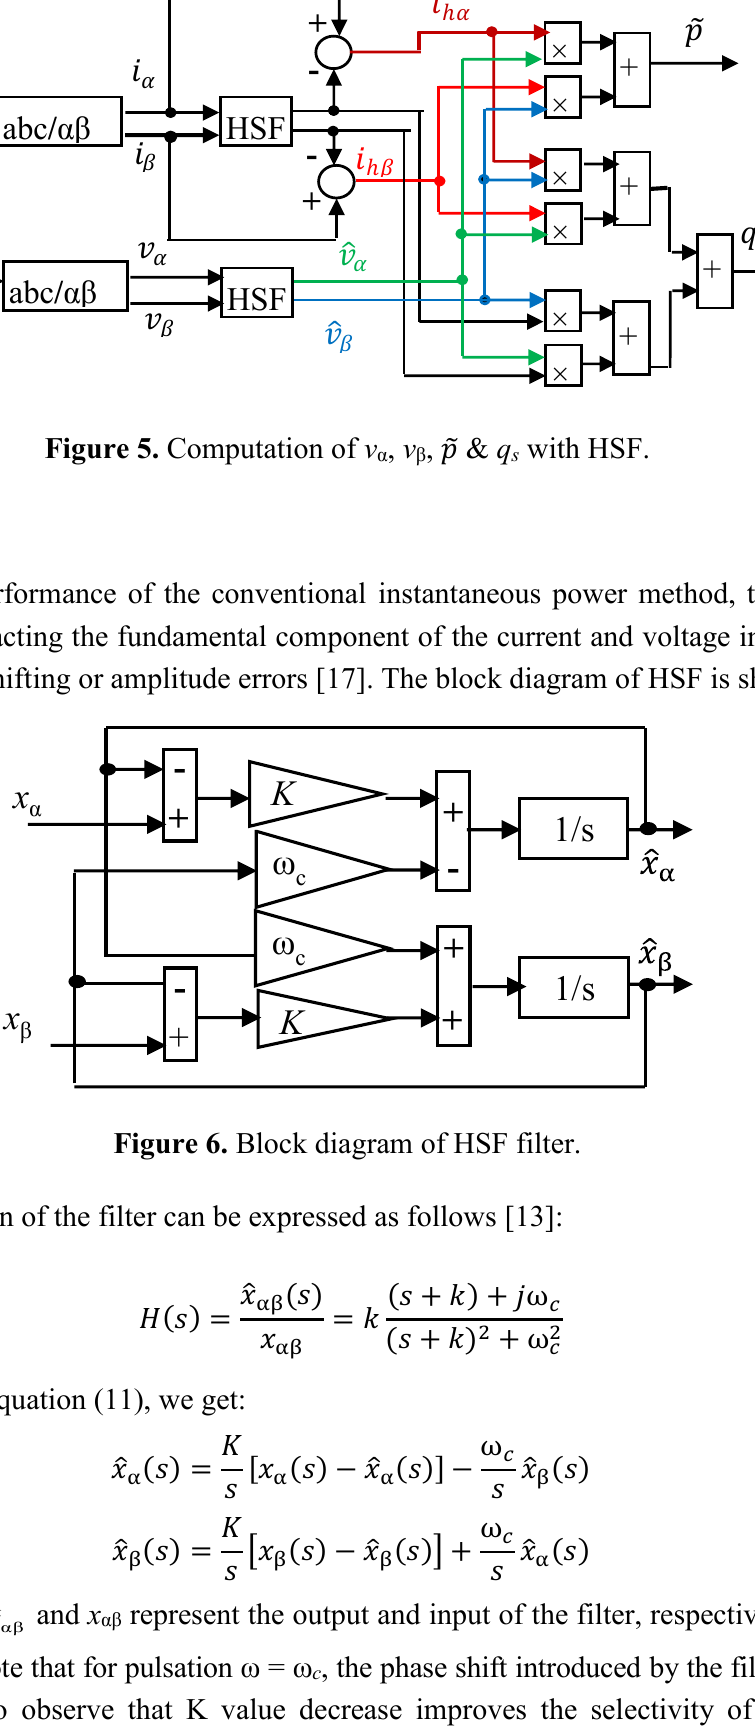
Figure 5 .Computation of vα, vβ, p ~ & qs with